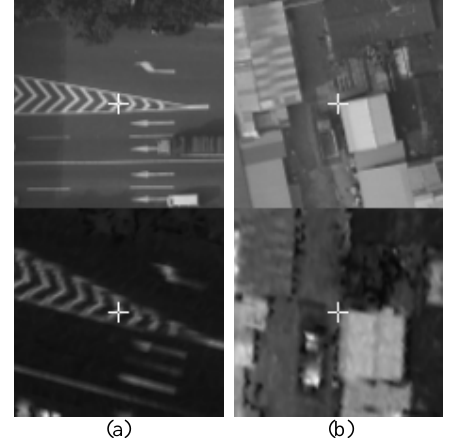
Figure 2. Part of conjugate points matched between the 1:3 aerial images and LiDAR intensity images (There are two sets of matching results (a), (b), the upper half part of each set is the 1:3 aerial image feature point and the bottom half is the conjugate point matched on LiDAR intensity, the cross indicates their